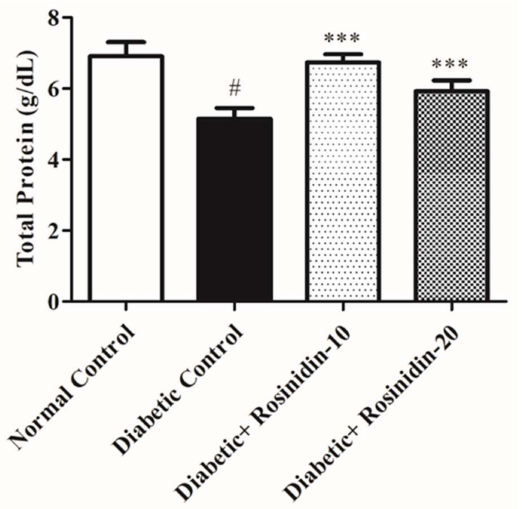
Figure 6. Effect of rosinidin on total protein against that of STZ-induced diabetic rats ( n = 6). Values are expressed as mean ± SEM. # p < 0.05, normal control vs. diabetic control; *** p < 0.001, diabetic control vs. rosinidin-10, rosinidin-20.